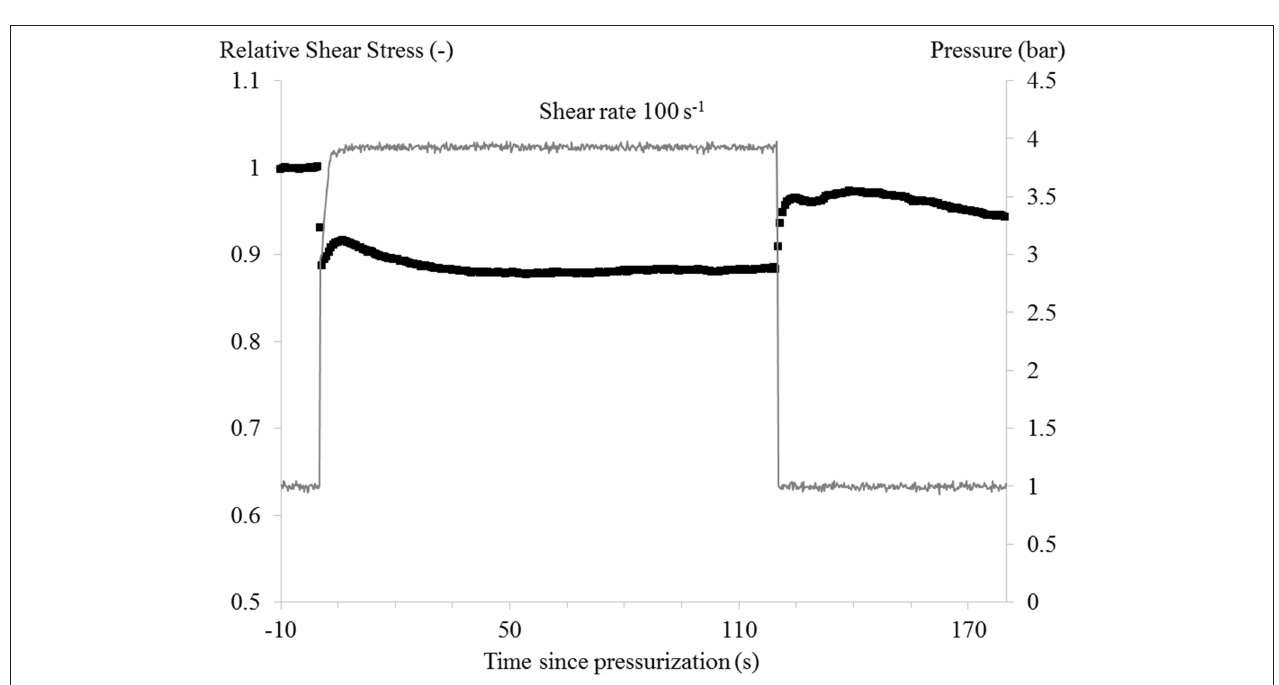
FIGURE 10 | Rate of air dissolution and reappearance at a shear rate of 100 s − 1 .